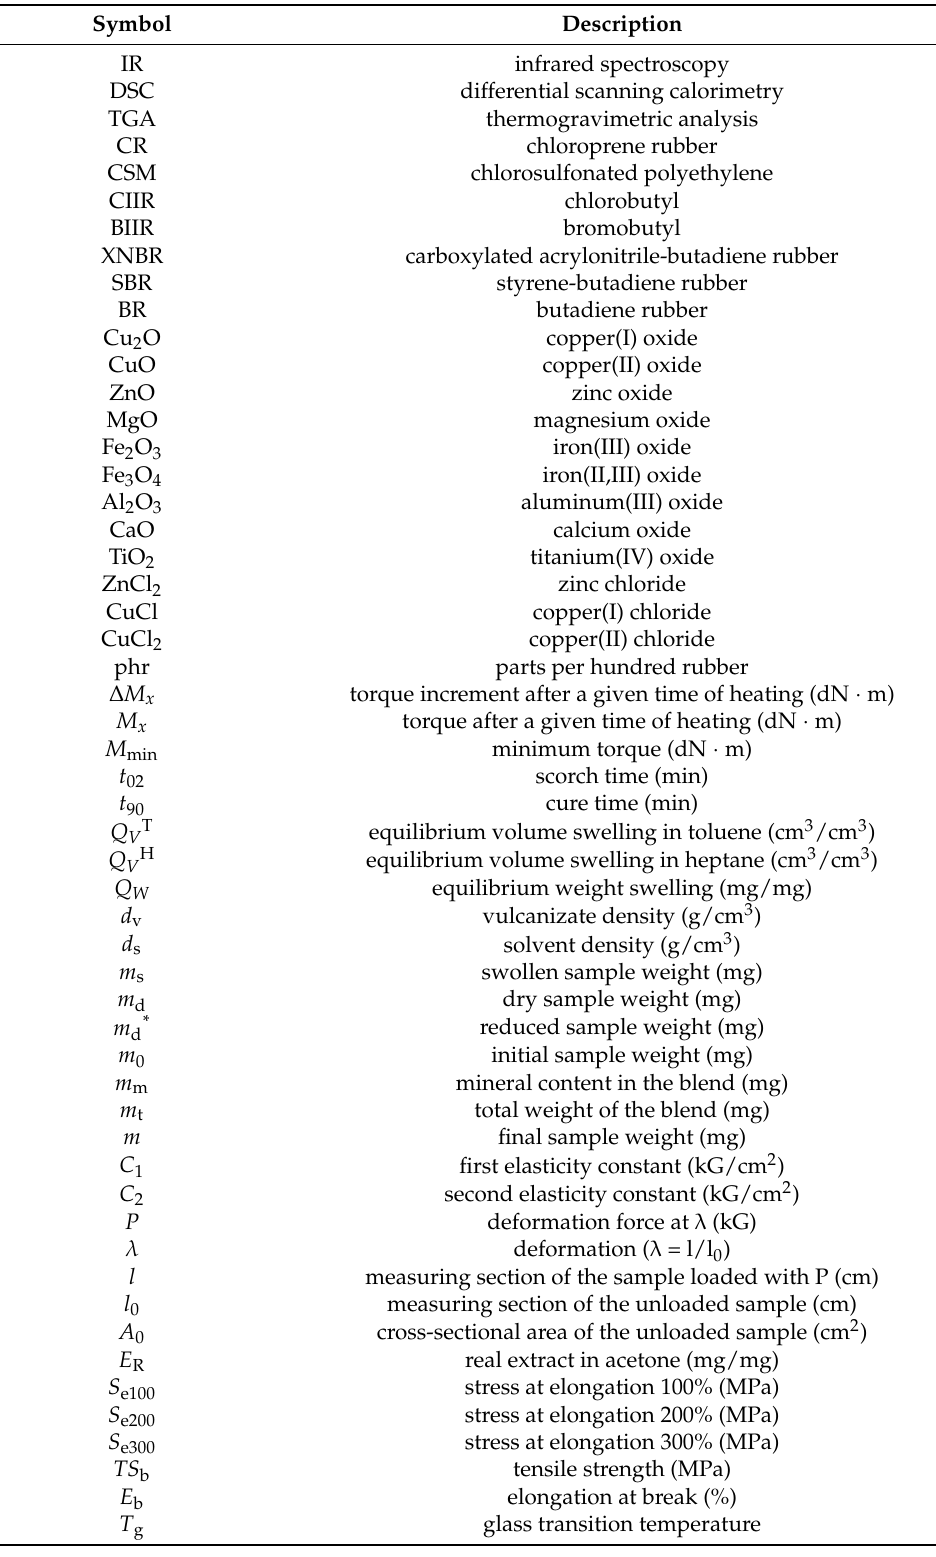
Table 5. List of abbreviations used in the article with